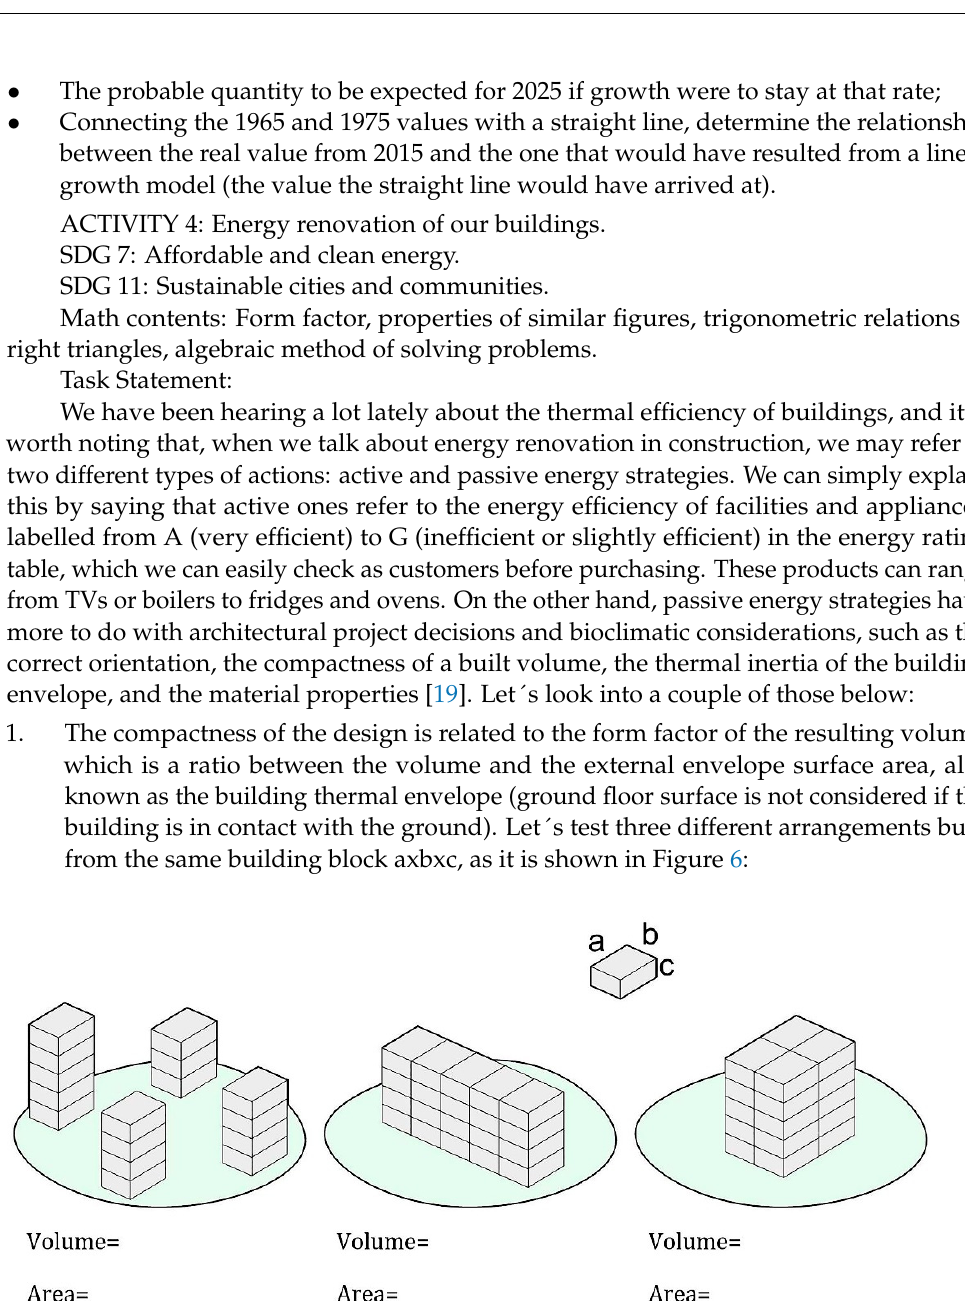
Figure 7. Thickness, thermal resistance, and the angle tangents. Own Source. Table 2. These are the numerical examples for each situation. First Case